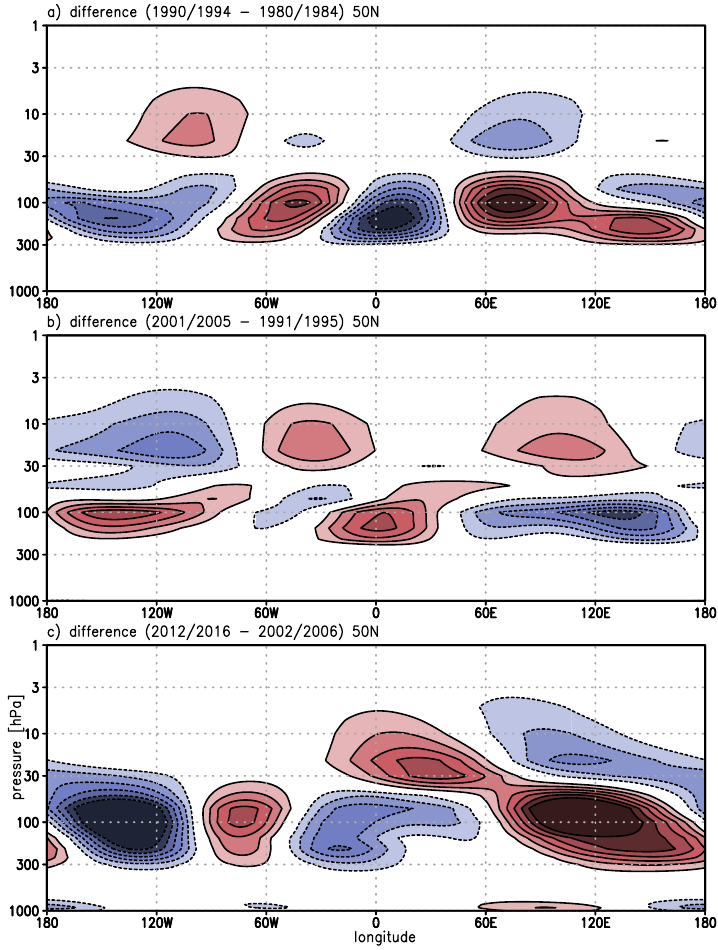
Figure 7. Model result: Pressure-longitude cross-section of the horizontal advection (first term of Equation (3), [DU/km]) at 50 ◦ N for January based on differences of different periods: ( a )1990/1994–1980/1984, ( b ) 2001/2005–1991/1995, and ( c ) 2012/2016–2002/2006. Absolte values above 0.2 DU/km are shaded with a contour interval